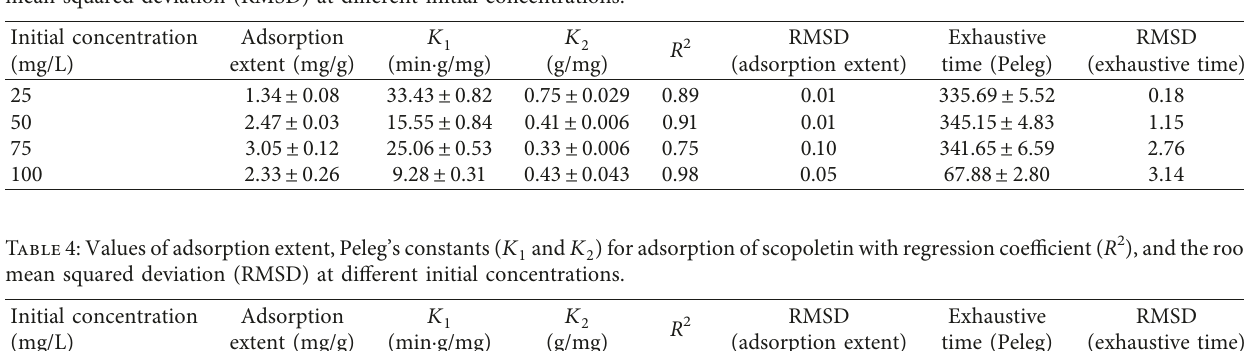
and K ) for adsorption of rutin with regression coefficient ( R 2 ), and the root 1 2